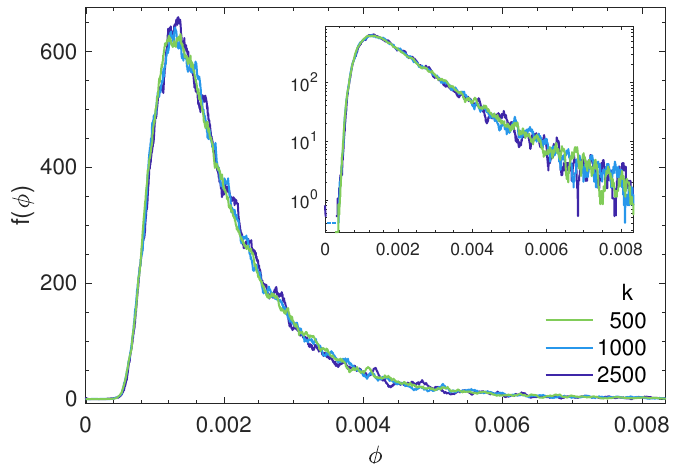
Figure 3. Distribution of the monomer softness f ( φ ) . Inset: Exponential tail of the distribution at large softness. A monomer is defined to be soft if φ ≥ 4.6 × 10 − 3 .